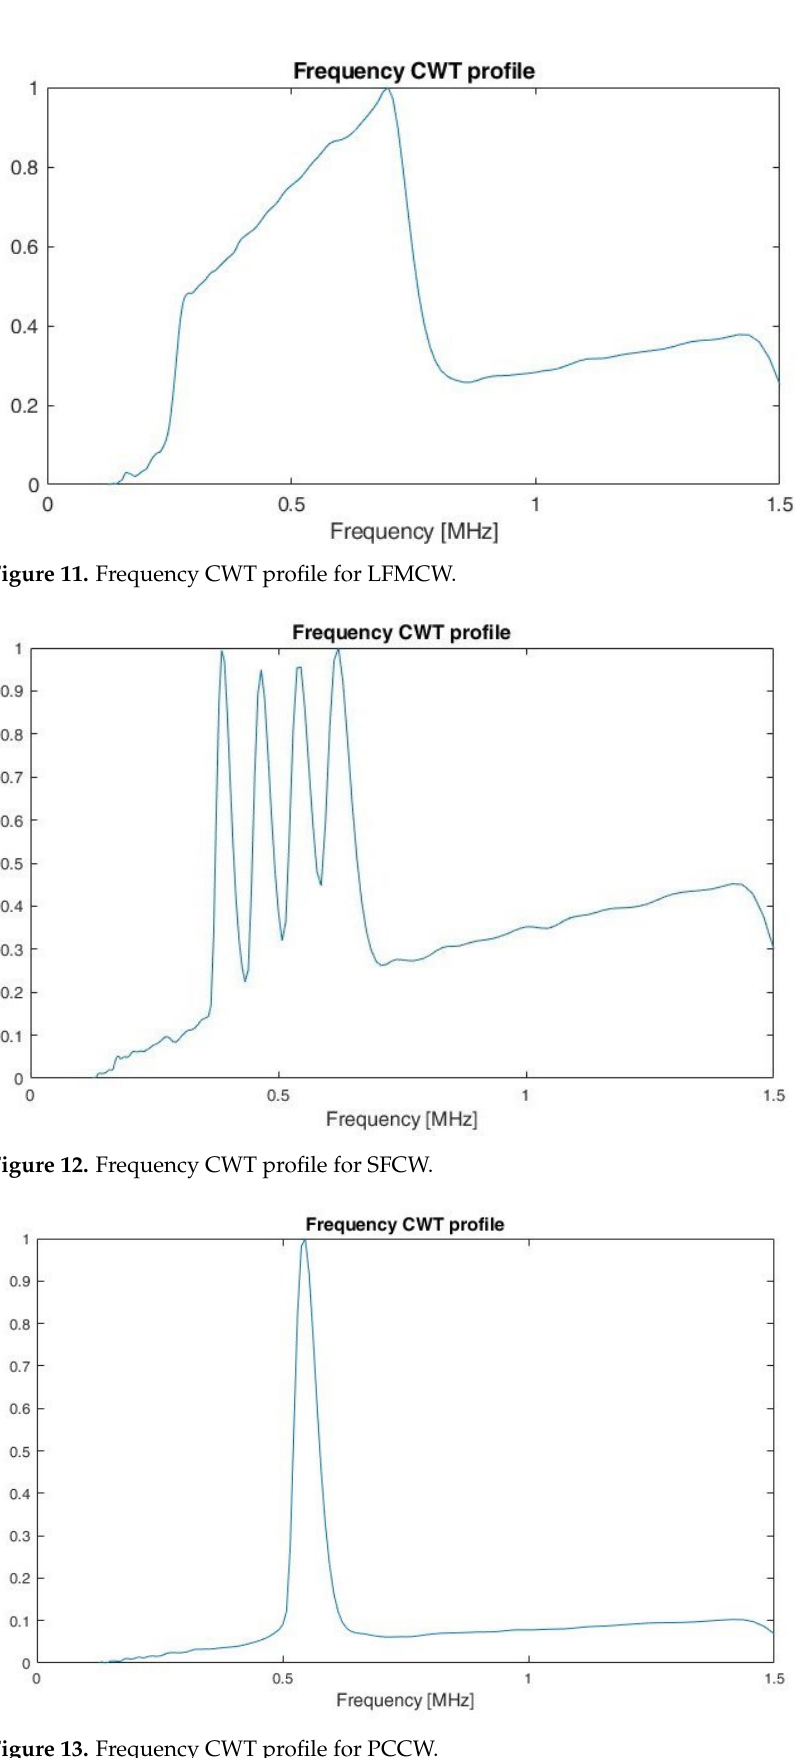
Figure 13. Frequency CWT profile for